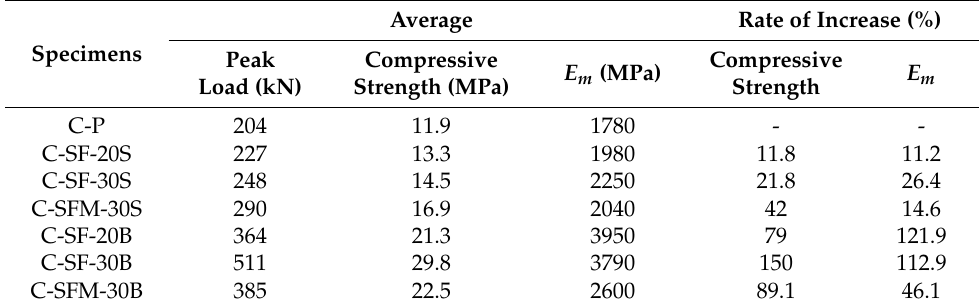
Figure 5. Compressive stress–strain curve: ( a ) C-SF-20S and C-SF-20B; ( b ) C-SF-30S and C-SF-30B; ( c ) C-SFM-30S and C-SFM-30B. Table 4. Compressive strength test result.